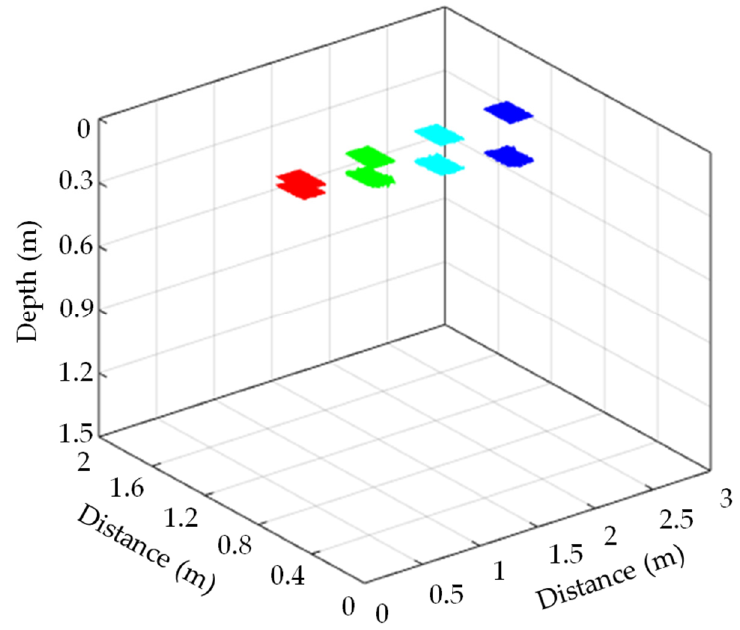
Figure 20. Three-dimensional surface maps formed from the characteristic values of void fillers.